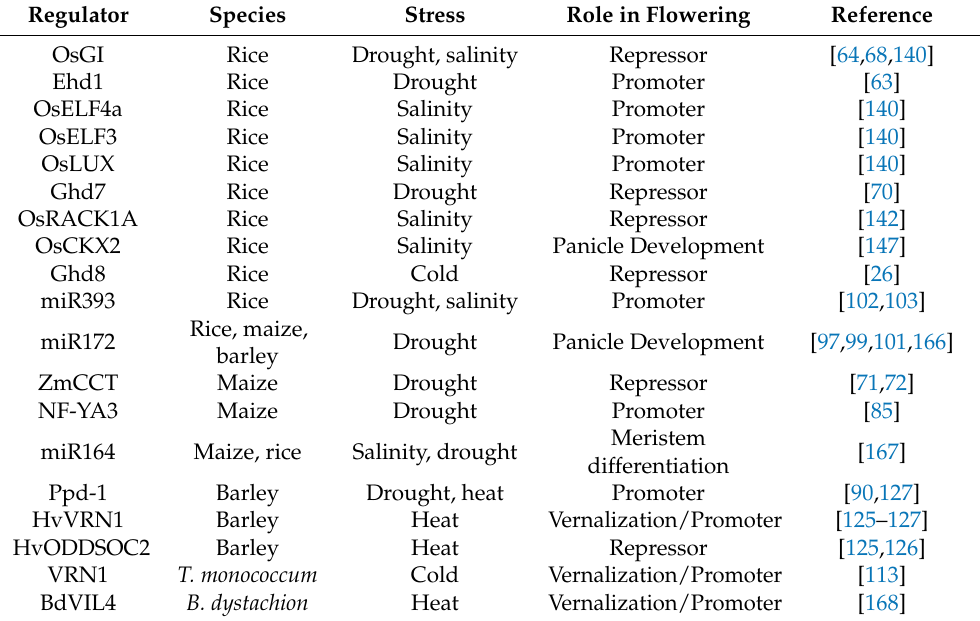
Table 1. Main flowering regulators of Poaceae integrating abiotic stress signalling into the heading control and flower developmental